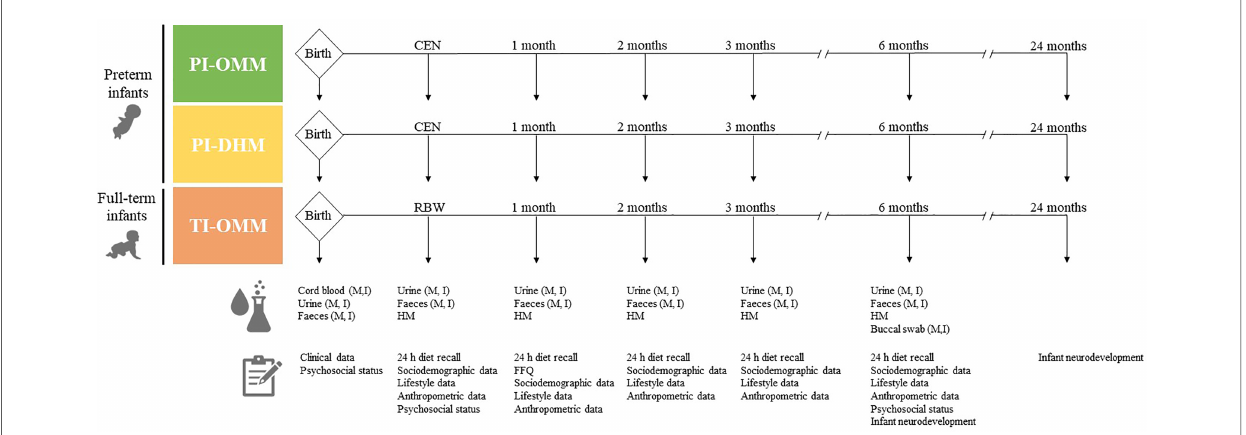
FIGURE 1 Design of the NUTRISHIELD study. PI, preterm infant; TI, term infant; M, mother; I, infant; OMM, own mother ’ s milk; DHM, donor human milk; CEN, complete enteral nutrition (150 ml/kg/day); RBW, recovery of birth weight; HM, human milk; FFQ, food frequency questionnaire.